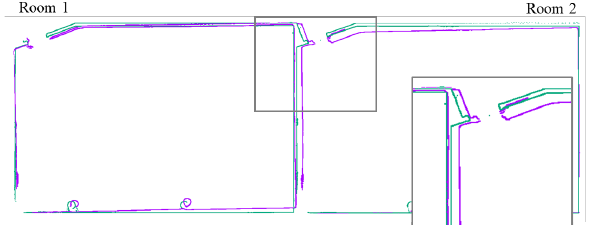
Figure 11. iPad point cloud (violet) and TLS point cloud (green) registered. Ceiling, floor and furniture have been deleted for visualization.